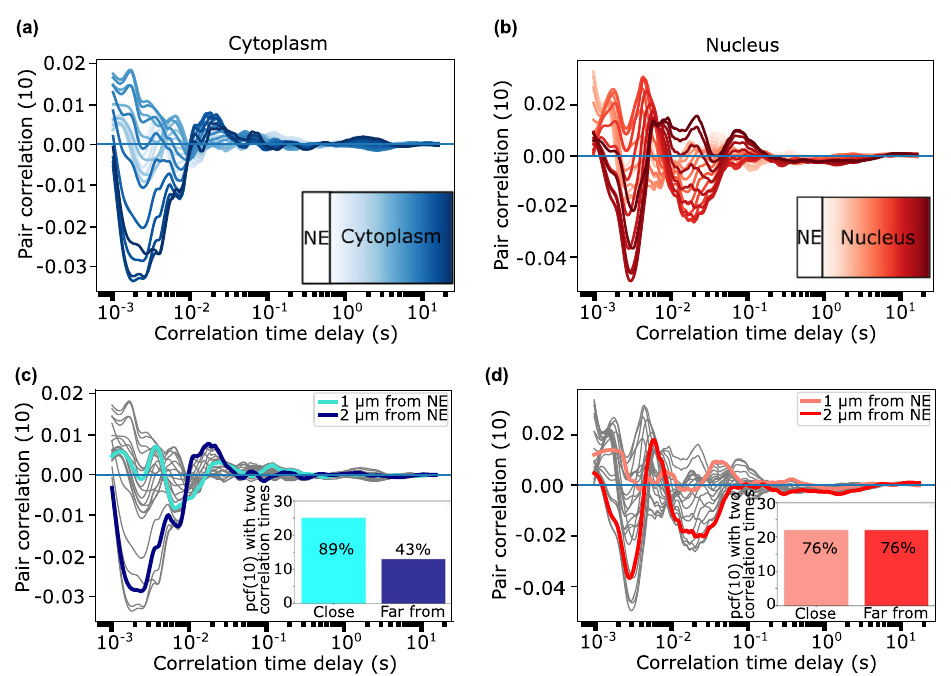
Figure 7. pCF analysis reveals C protein import and export. A pCF analysis of nucleocytoplasmic C-DENV transport shows the C-protein shuttles in both directions. From the complete intensity kymogram we select the region (pixels 14 to 42) in the cytoplasm (or nucleus) that at a distance of 10 pixels entirely correlates with the nucleus (or cytoplasm). ( A ) pCF kymograms analyzed in a direction from cytoplasm to nucleus (dashed green line in C ). ( B ) pCF kymograms analyzed in a direction from nucleus to cytoplasm (solid green line in C ). ( C ) Average pCF(10) of lines crossing NE calculated for the kymograms shown in ( A , B ). The transport of C-protein from cytoplasm-to-nucleus is favored compared with that of C-protein diffusing in the opposite direction as indicated by the amplitude of the pCF peaks. ( D ) Box plot for each direction, C-entry indicates cytoplasm to nucleus direction with an interquartile range of 2 to 11 ms. C-exit indicates nucleus to cytoplasm direction with an interquartile range of 8 to 19